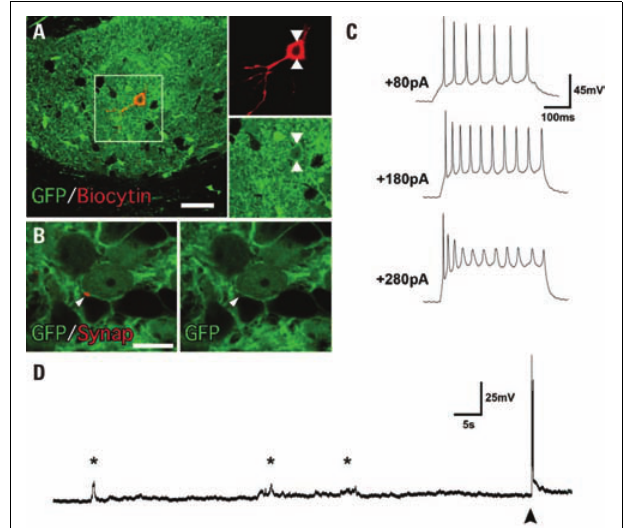
FIGURE 9 | Functional properties of human ES cell-derived neurons 10 weeks after transplantation. (A) The neuronal identity of the cells analyzed under patch-clamp was confirmed by co-expression of GFP and biocytin. (B) Immunohistochemistry for synaptophysin showed punctate labeling of GFP + cells with neuronal morphology. (C) An example of a voltage recording from an individual neuron demonstrating action potential firing at depolarized potentials. Increased action potential firing occurred with increasing current injection. (D) Excitatory post-synaptic potentials are clearly evident on the voltage trace recorded from an individual neuron. In some cases they depolarized the neuron sufficiently to fire action potentials (filled arrow). Scale bar: (A) 50 μ m, (B) 25 μ